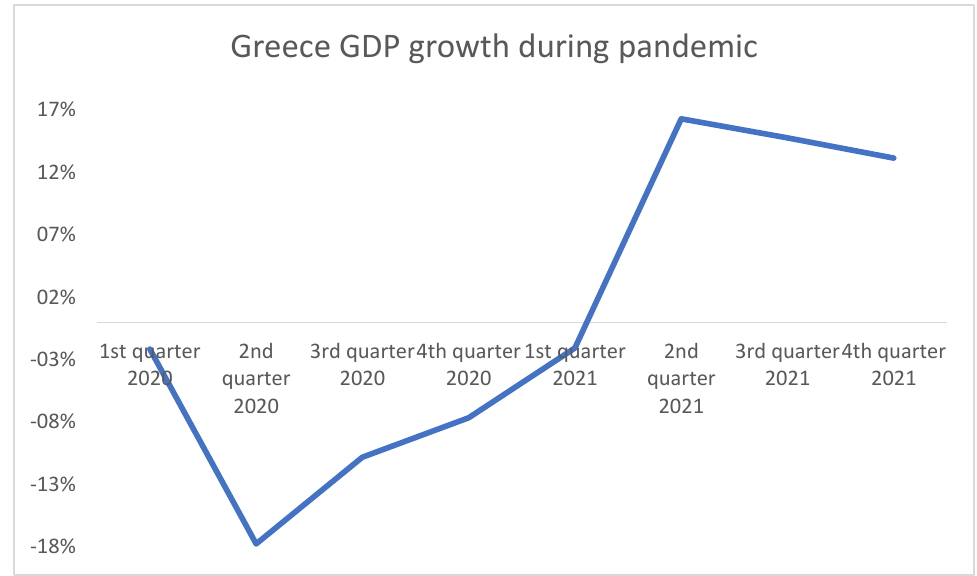
Figure 2. Greece’s GDP growth rate during the pandemic crisis. Source: Eurostat.